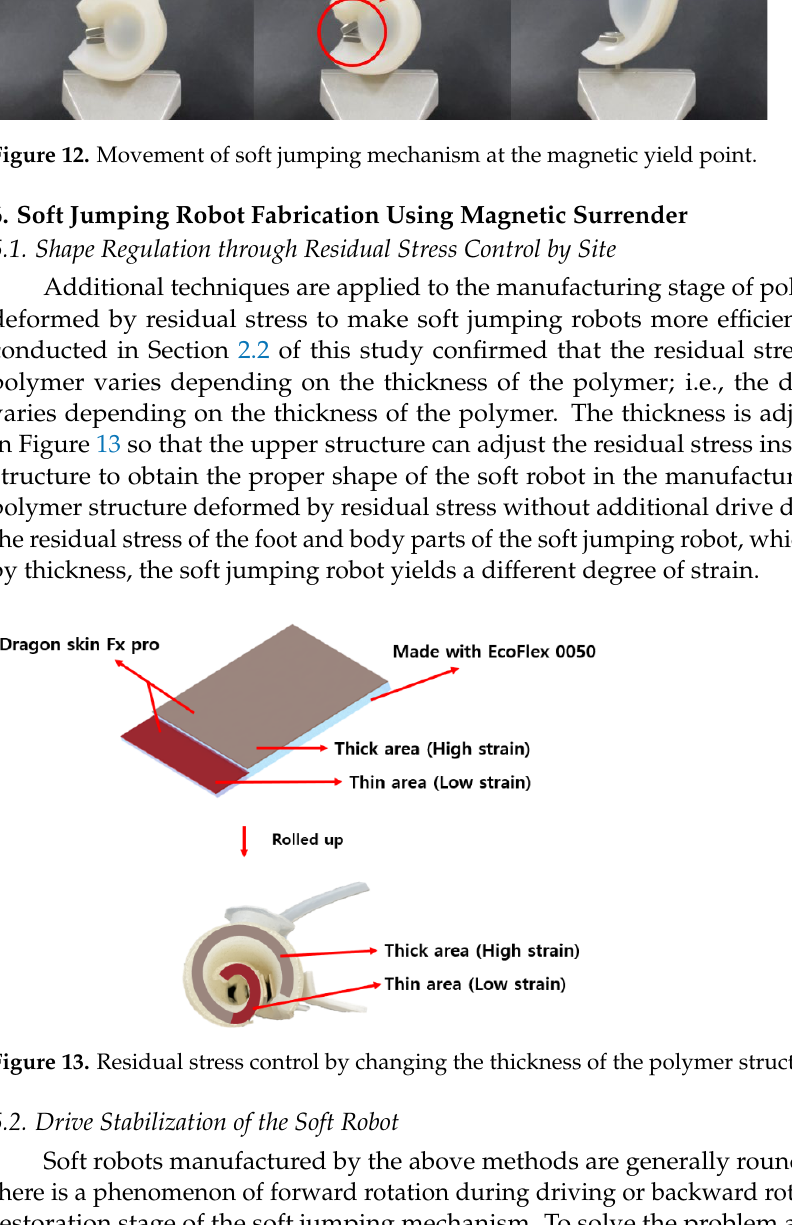
Figure 14. Final design of soft jumping robot. ( a ) Attachment position of front foot; ( b ) magnet for drive stabilization of soft jumping robot. The attached silicon structures can improve the phenomenon of the rolling forward because of inertia as shown in Figure 15, where the robot can land stably after jumping. The soft jumping robot’s back foot does not pull the whole body due to friction with the floor surface of the silicon structure in the middle; instead, the rear foot is pulled to the main body side. ( a ) ( b ) Figure 15. Comparing landing motion for mounting front foot; ( a ) Landing motion before mounting front foot. ( b ) landing motion after mounting front foot type